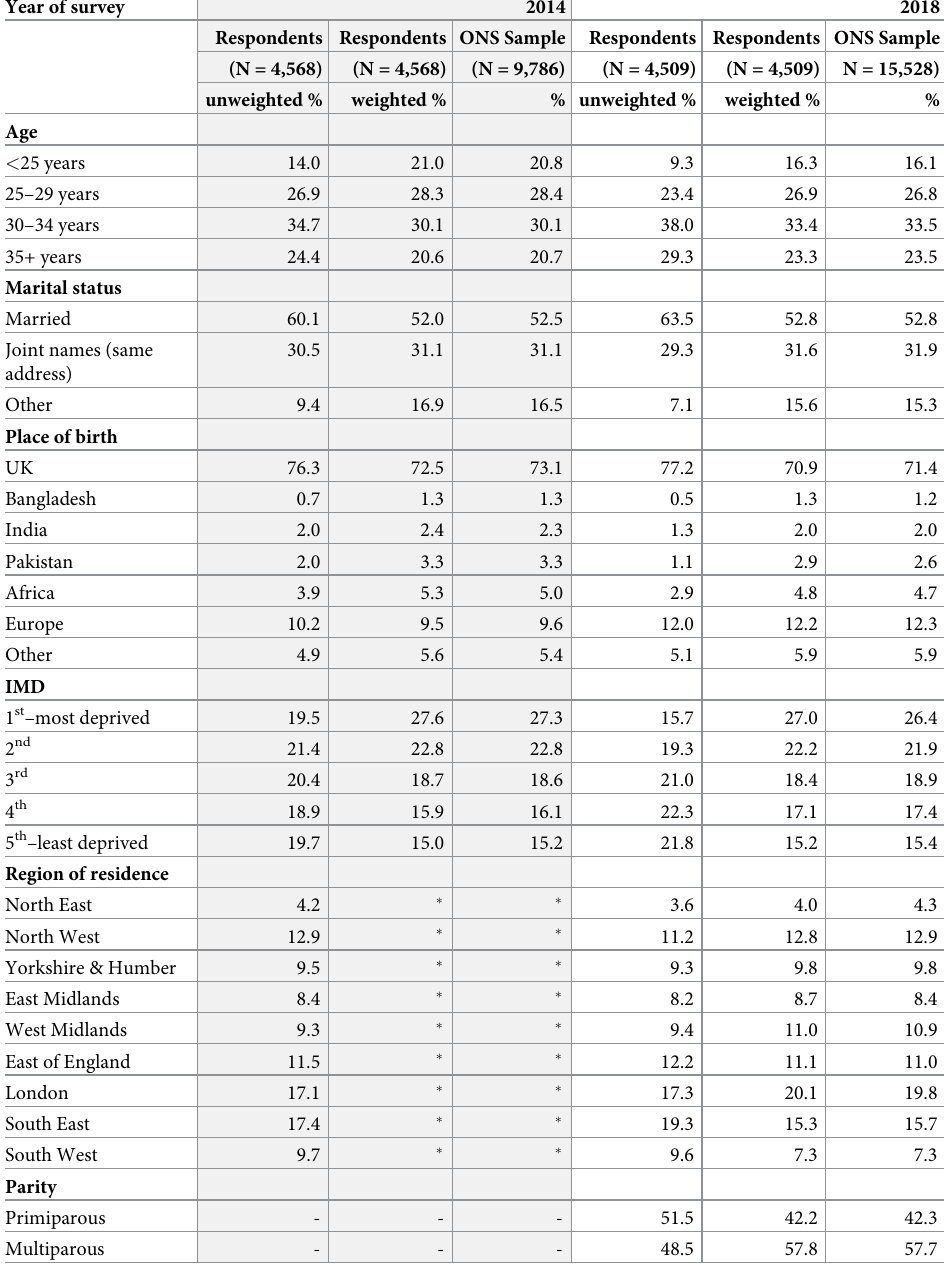
Table 3. Unweighted and weighted distributions of respondent demographic characteristics used to calculate the weights in the 2014 and 2018 national maternity surveys (compared to overall sample). Year of survey 2014